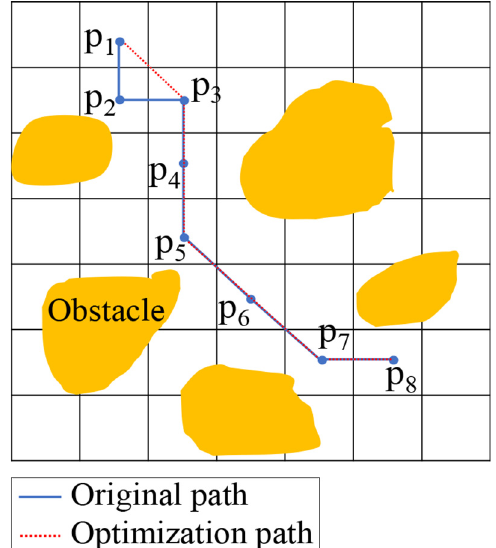
Figure 4 Schematic of node